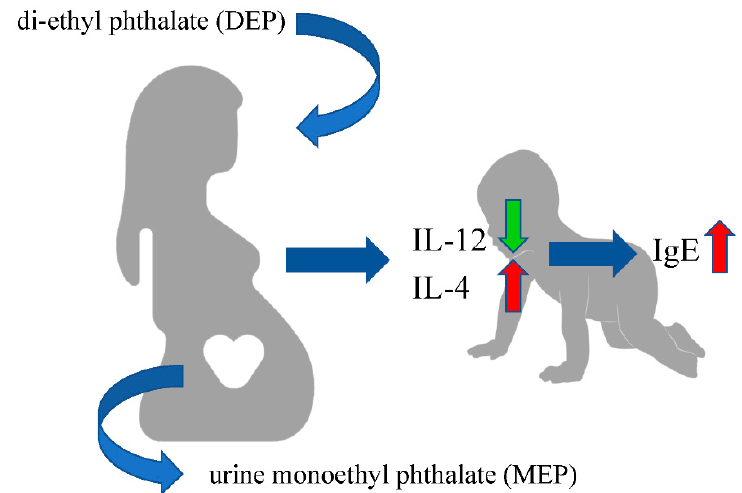
Figure 4. The possible link between prenatal DEP exposure and alternation of Th1/Th2 polariza- tion related cytokines and neonatal IgE level.The risk of developing allergic disease is likely to be multifactorial, depending on individual genetic susceptibility and environmental exposure. Many risk factors related to childhood allergic diseases have been demonstrated, which include genetic atopic predisposition, early childhood allergen exposure and sensitization, occurrence of viral respiratory infections in young children, maternal smoking during pregnancy, poor dietary factors, lack of breast-feeding, childhood obesity, having a certain immunologic (Th2-prone) predisposition, air pollution, and frequent immunizations in childhood [17]. Our study demonstrated a positive association between IgE in the maternal plasma and cord blood IgE. This result is consistent with the studies of Nabavi et al. and Amici et al., which suggest that the transfer of cytokines and chemokines through the placenta and the gaining of access to the gut-associated lymphoid tissue can lead to the overproduction of IgE [18,19]. However, in our study, we found that the maternal urine MEP level only positively correlated with cord blood IL-12p70 levels but not with the level of IL-12p70 in the maternal plasma. The positive correlation of maternal plasma IgE with the cord blood IgE can also be partially explained by genetic atopic predisposition, because mothers with atopy often have higher IgE levels.